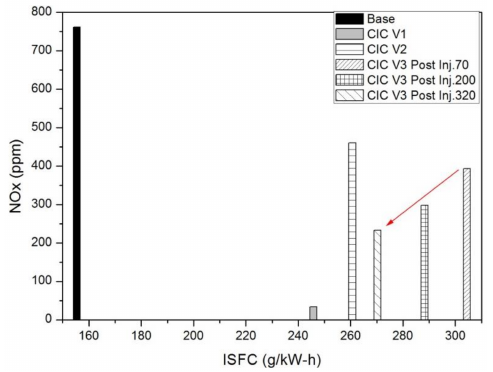
Figure 17. Comparison on ISFC versus NO x for different variable valve control strategies.